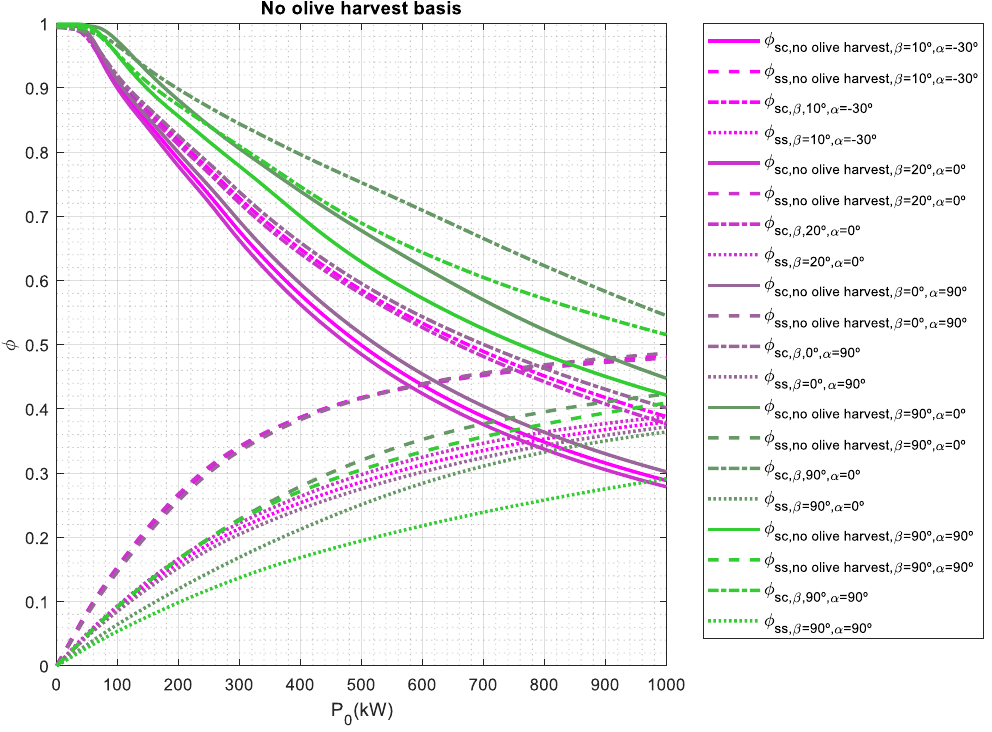
Figure 8. No harvest basis. Φ sc and Φ ss curves which maximizes and minimizes Φ Figure 8 No harvest basis. Ф sc and Ф ss curves which maximizes and minimizes Ф ss.